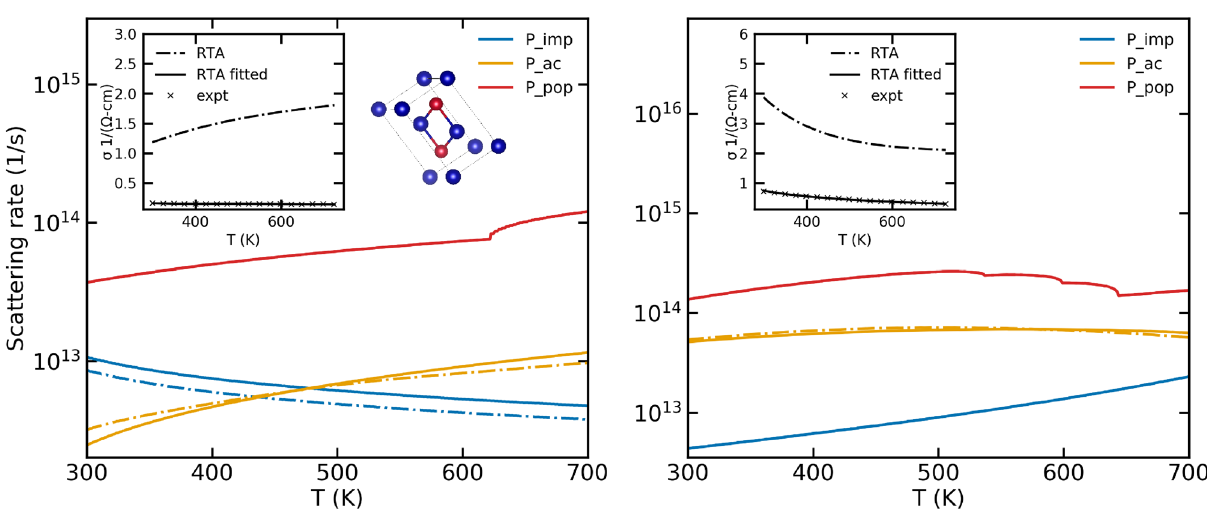
Figure 6. A comparison of the scattering rates in Mg 3 Sb 2 obtained using the original scattering models (RTA) and those obtained using the fitting procedure (RTA fitted ). The left panel corresponds to an n-type sample with a doping concentration of 3.6 × 10 18 cm − 3 while the right panel corresponds to an n-type doping of 3.6 × 10 19 cm − 3 . The inset shows the electrical conductivity calculated using the respective scattering rates.The experimental data have been obtained from Ref.